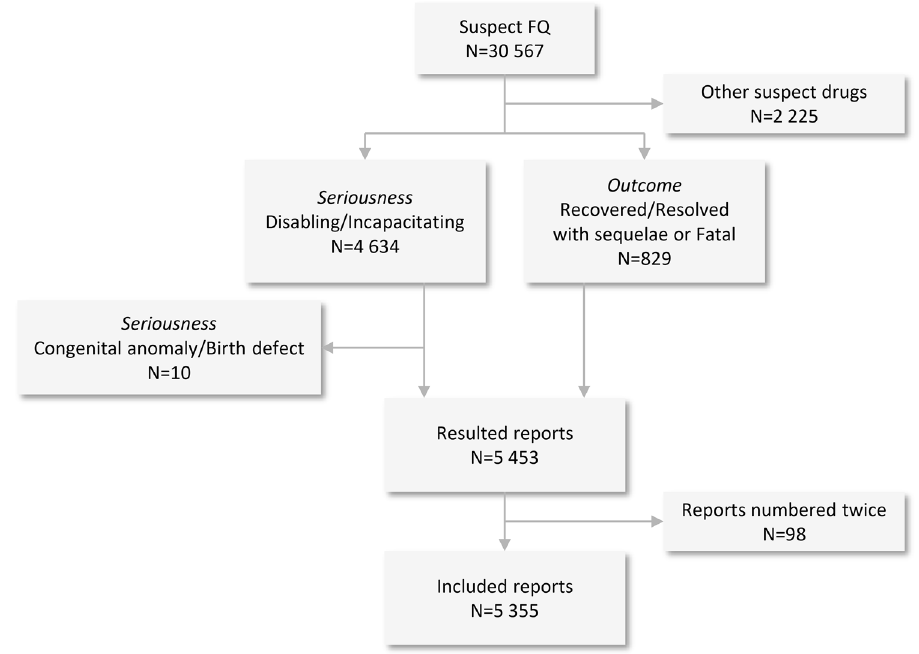
Figure 1. Overview of inclusion and exclusion